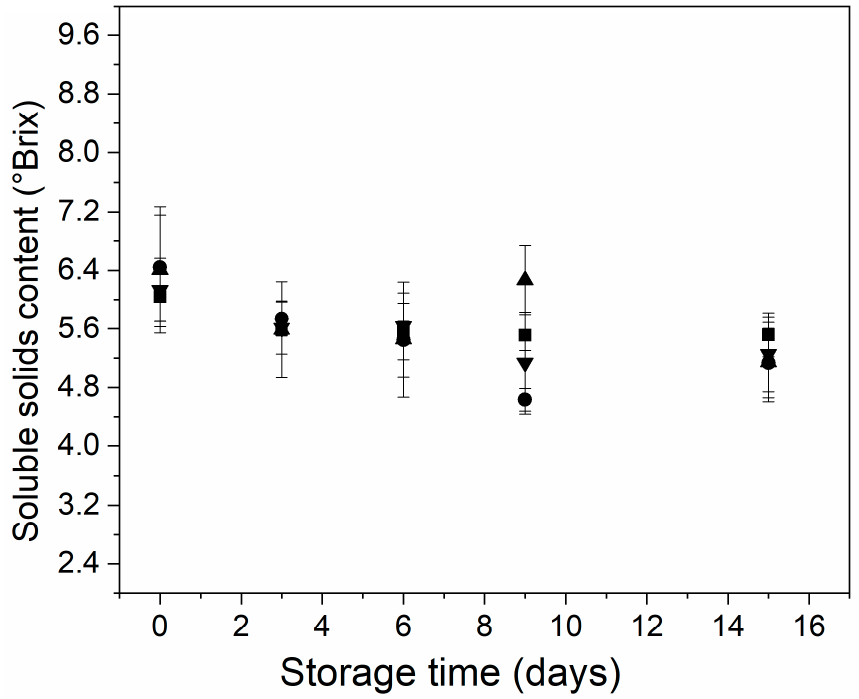
Figure 4. Behavior of the soluble solids content of control and treated minimally processed bunching green onion during storage. Control ( ■ ); mild-heat treatment ( ● ); edible coating ( ▲ ); mild-heat treatment+ edible coating ( ▼ ).